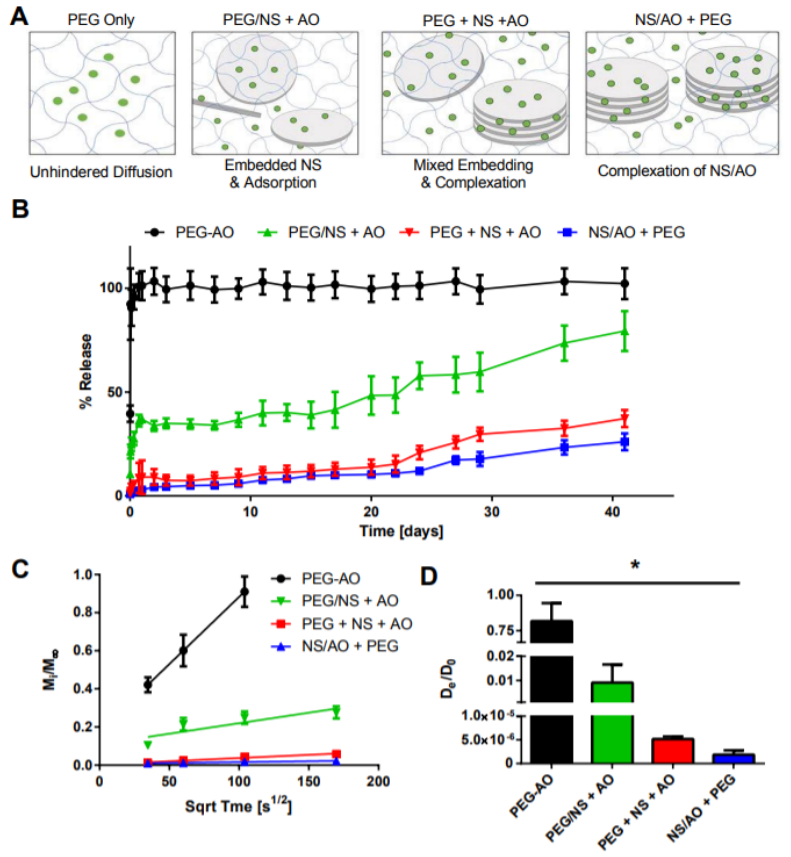
Figure 6. Effect of AO loading method on AO release. ( A ) Schematic of preparation conditions tested, where green dots indicate AO, blue lines represent the PEG hydrogel mesh network, and gray discs represent the NS particles. ( B ) Bulk release of AO. ( C ) Fractional release of AO as a function of the square root of time. ( D ) Calculated effective diffusion coefficient for each condition. * indicates statistically significant difference between all groups ( n = 3, p < 0.05) as indicated by an ANOVA followed by Tukey’s post hoc test.